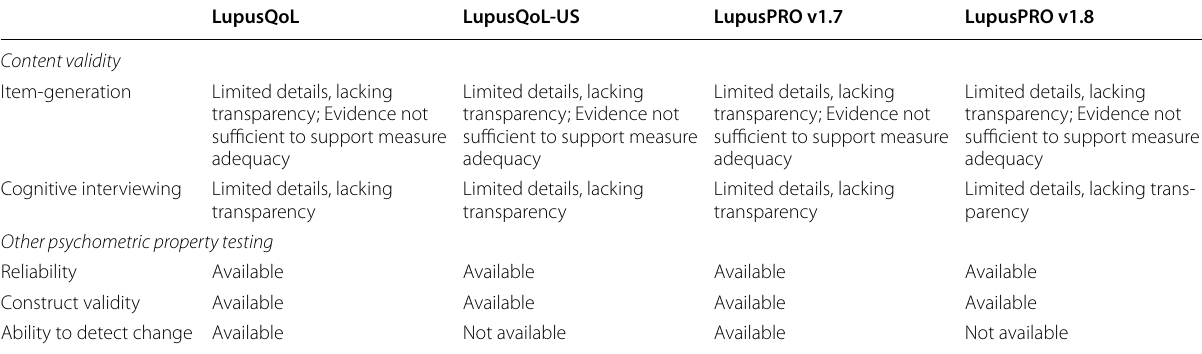
Table 4 Summary of data abstraction and assessment notes for measurement properties and documentation using evaluation criteria by phase for patient‑reported outcome measure‑development across SLE‑PRO